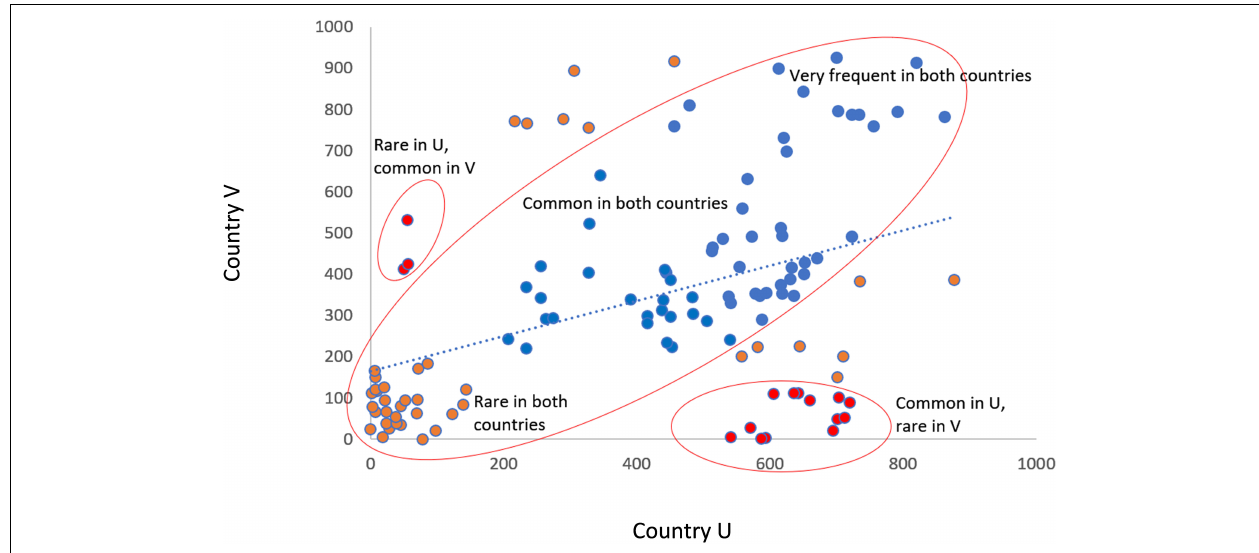
FIGURE 2 | Scattergram of the frequency of 120 item features in two hypothetical samples of 1,000 Grade 5 science items from two countries.